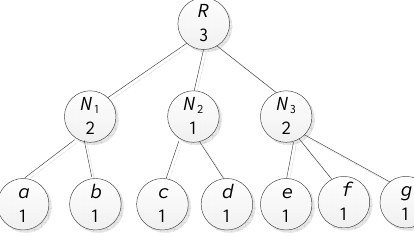
Figure 1. An example of the access